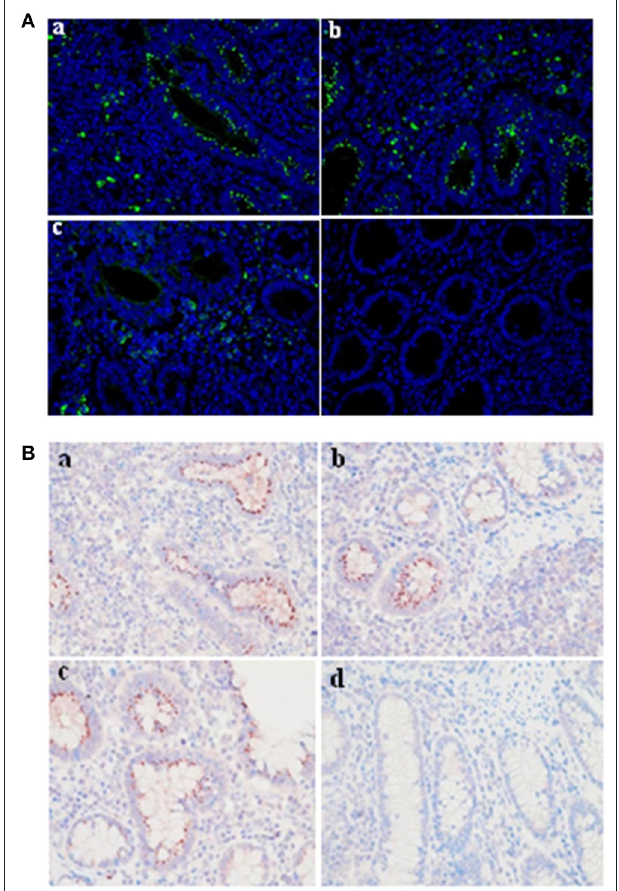
FIGURE 7 | Evaluation of the monoclonal antibody by immunofluorescence and immunocytochemistry in infected tissue of PPE. IF and IHC assays were conducted in a blinded fashion on parallel sections. (A) Immunofluorescence assay. The presence of L. intracellularis by IF was detected using L. intracellularis- specific monoclonal antibody (4D9, 3G2, and 7G5) (green), nuclei were counterstained with DAPI (blue). (B) Immunocytochemistry assay. The presence of L. intracellularis by IHC was detected using L. intracellularis- specific monoclonal antibody (red), nuclei were counterstained with hematoxylin (blue). (a) 4D9 MAb; (b) 3G2 MAb; (c) 7G5 MAb; (d) negative control. ×